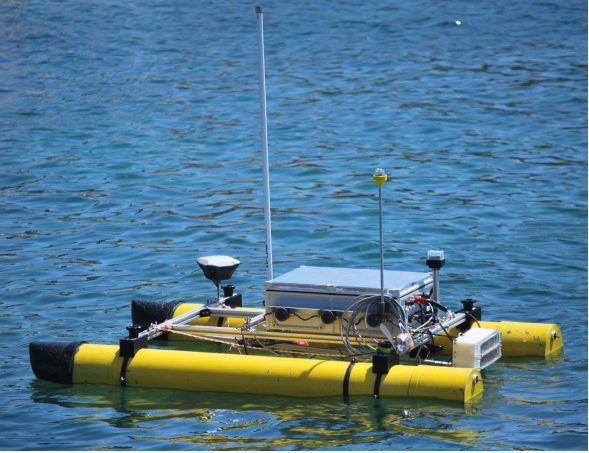
Figure 1. Xiroi II ASV